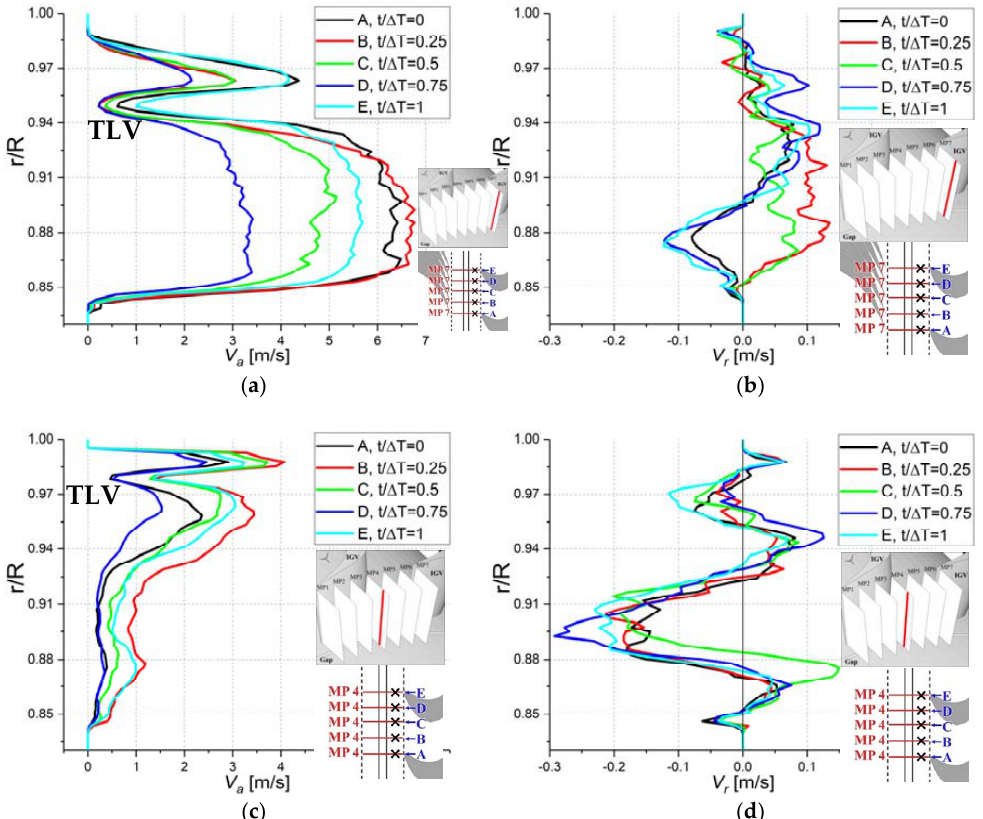
Figure 5. Velocity distributions at different rotor positions along annulus height in Case 1. ( a ) MP7; ( b ) MP7 (cid:1848) (cid:3045) (cid:1848) (cid:3028) ; ( c ) MP4 (cid:1848) (cid:3028) ; ( d ) MP4 (cid:1848) (cid:3045) . Tip leakage vortex (TLV).